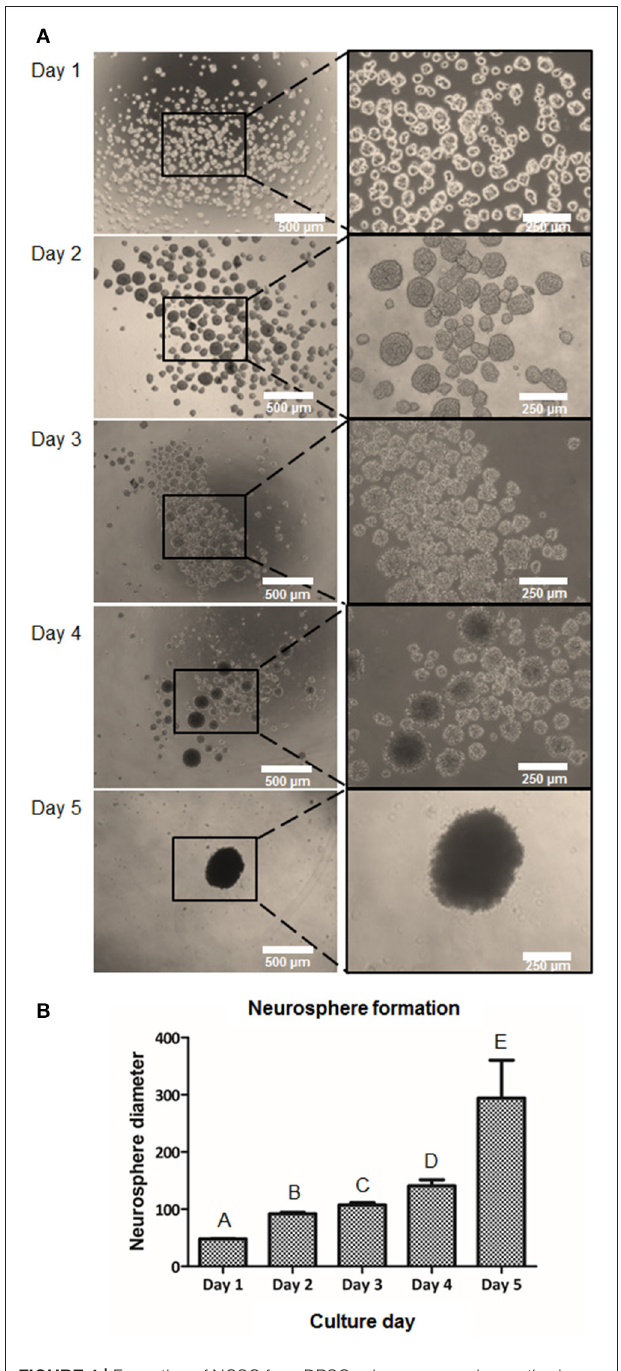
FIGURE 4 | Formation of NCSC from DPSC using a suspension method. Microscope images of cell morphology at days 1, 2, 3, 4, and 5 of NCSC formation in suspension culture (A) . Neurosphere diameter at days 1–5 of suspension culture (B) . *Scale bars: 500 µ m (lower magnification) and 250 µ m (higher magnification). **Data presented are means ± SD. Different letter denotes significant differences ( p < 0.05). Same letter denotes non-significant